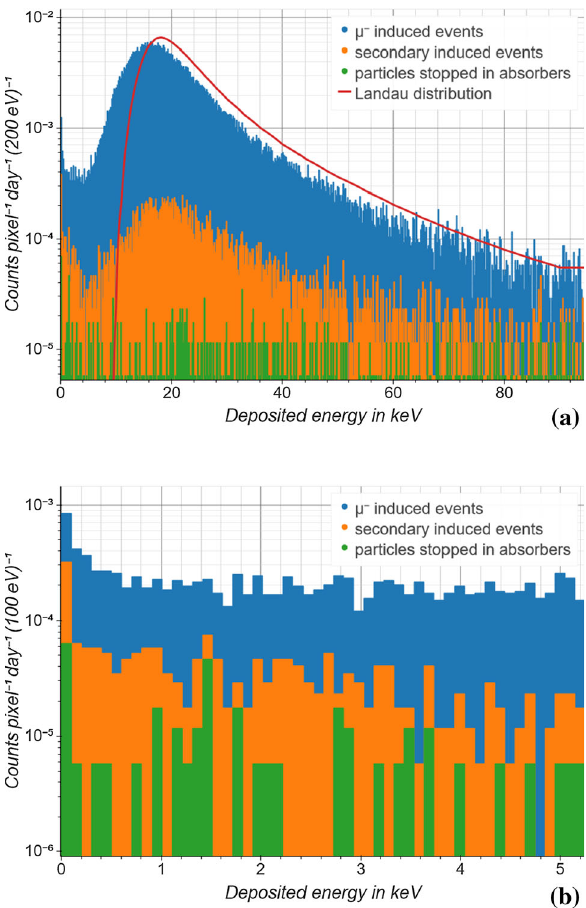
Fig. 5 a Simulated spectrum of the deposited energies in the detector pixelscausedbymuons(blue)andparticles,mostly δ -rays,generatedby muons (orange). The total energy ( ≈ caused by muon hits) distribution follows the Landau distribution (Fig. 3) for a thickness of 10 µ m ,but only for energies larger than 10 keV. b The spectrum in the sensitive region is nearly flat